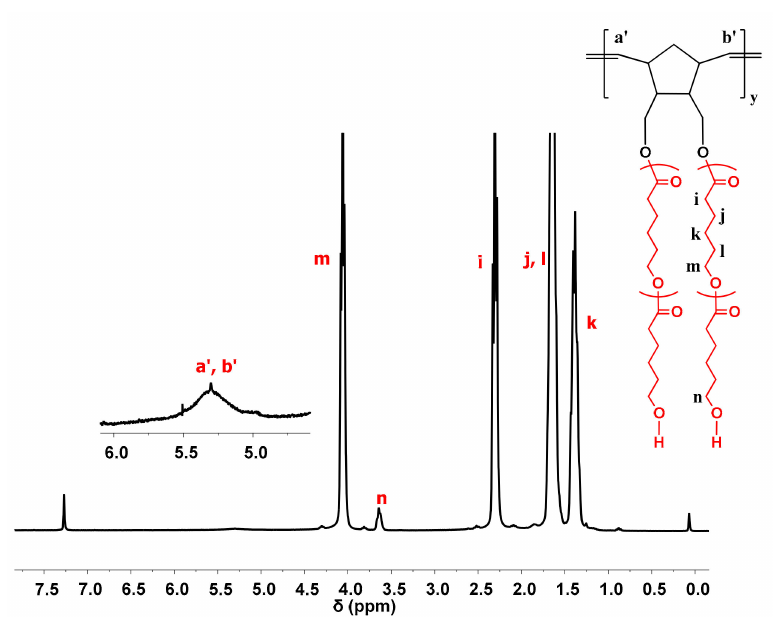
Figure 8. 1 H NMR spectrum of sample DB-PCL in CDCl 3 .